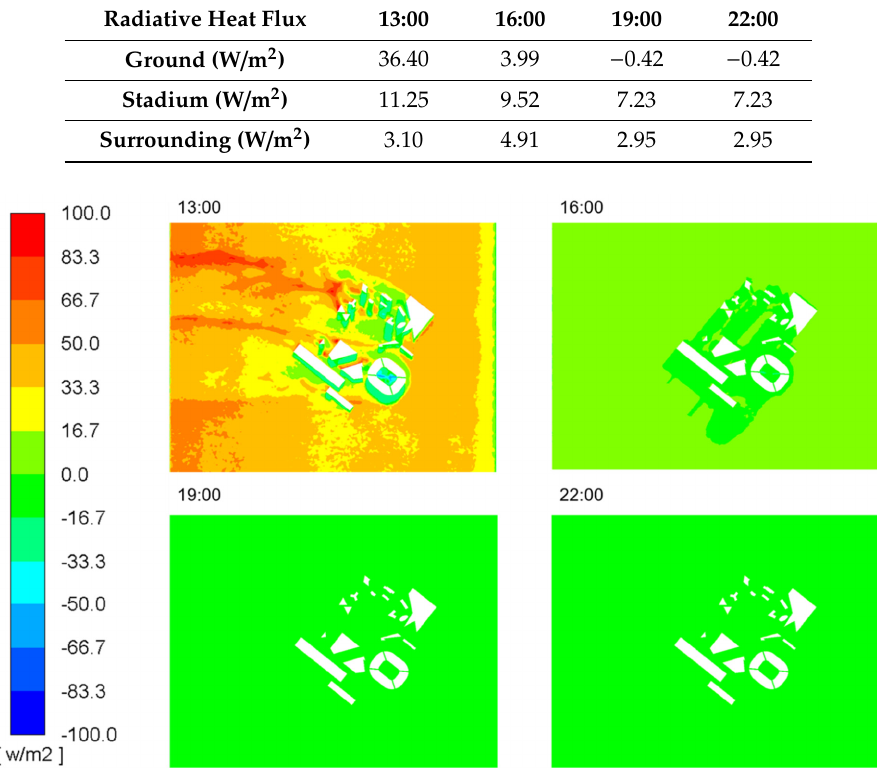
Figure 9. Radiation heat flux contours of the ground for the kick-off times 13:00, 16:00, 19:00 and 22:00 GMT+3 (Doha time) on 21 November.